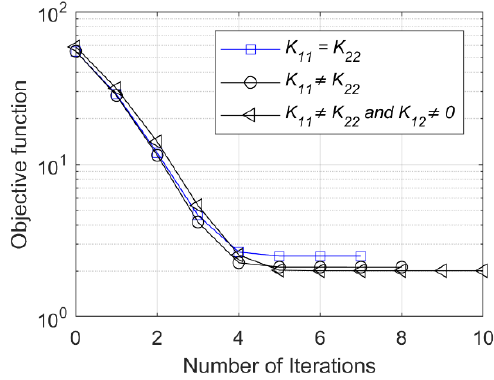
Figure 6. Objective function and number of iterations, with 𝐾 11 = 𝐾 22 and 𝐾 11 ≠ 𝐾 22 .